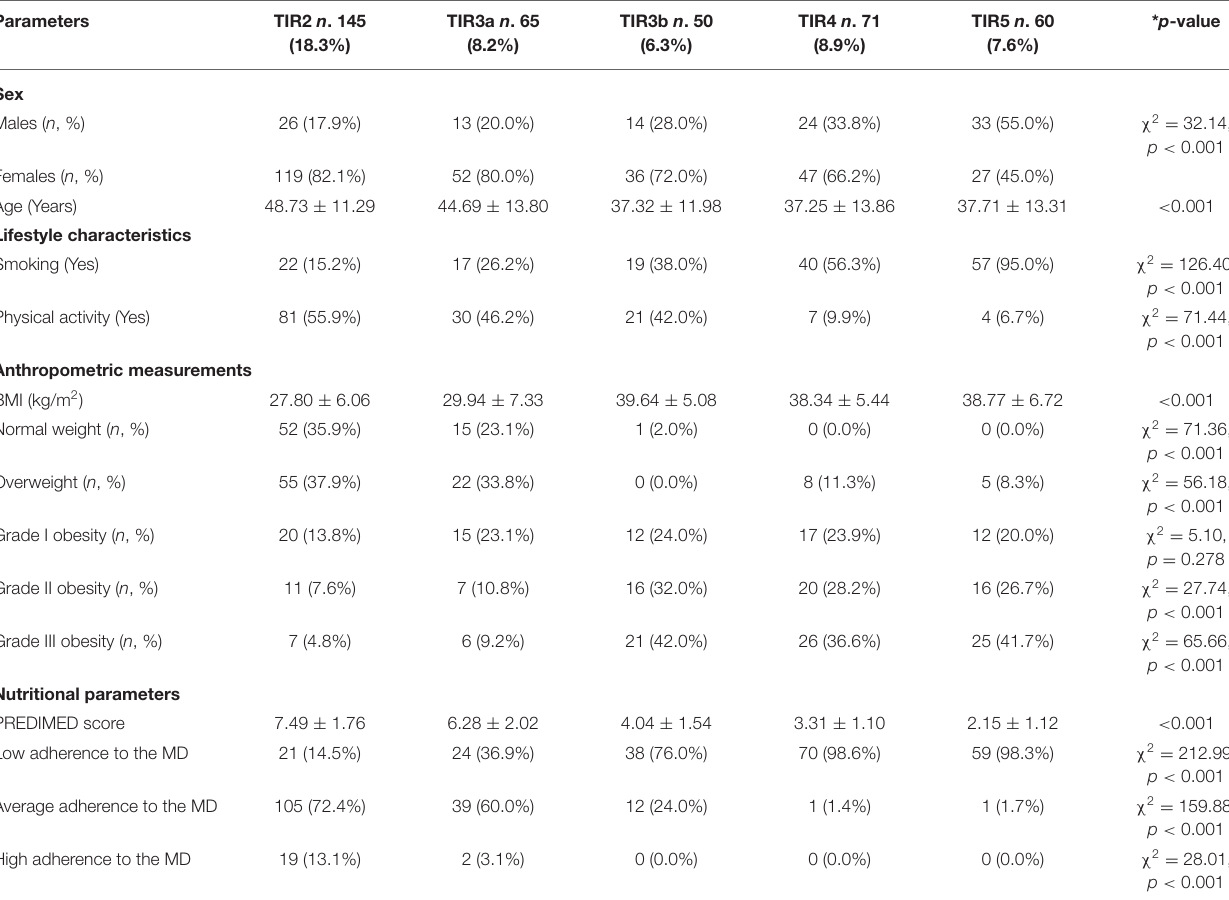
TABLE 4 | Gender, age, lifestyle characteristics, anthropometric measurements, and nutritional parameters of the study population according to the five diagnostic cytology categories based on 2013 Italian thyroid cytology classification system.